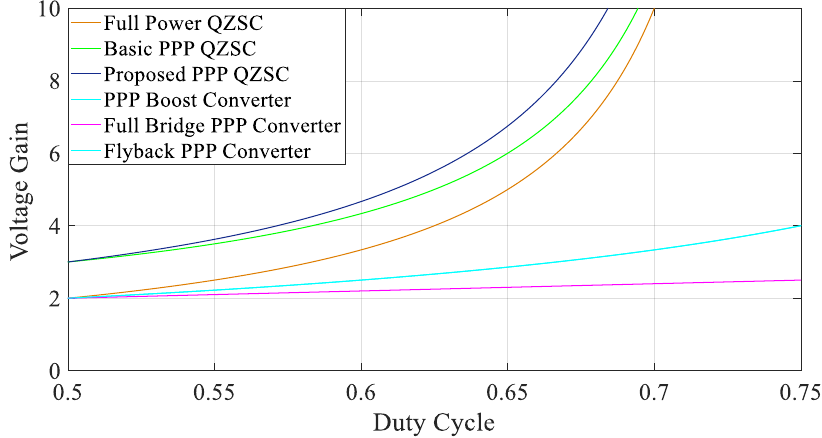
Figure 5. Voltage gain versus duty cycle for three discussed converters and PPP structures of Flyback, H-bridge, and Boost converters (Flyback and Boost have similar waveform).